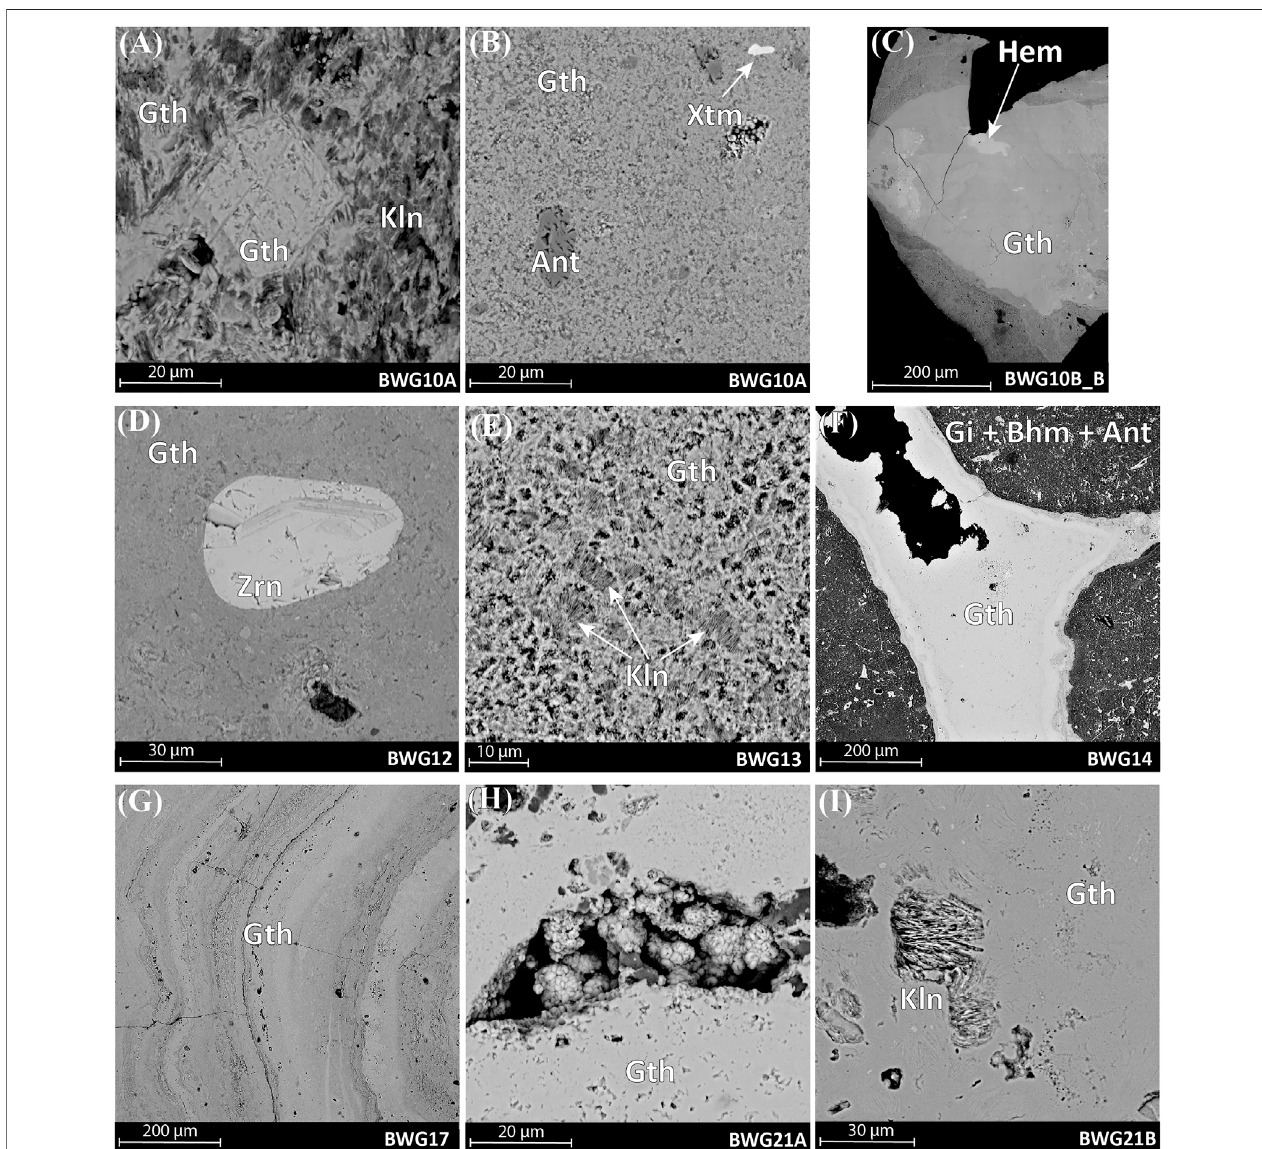
FIGURE5| Scanningelectronmicroscopyimages. (A) Detritalgoethite( G th)surroundedbyintergrownkaolinite(Kln)bookletsandcheckeredsecondary goethite. (B,D) Contaminant can be present in dated aliquots, for example, anatase (Ant), xenotime (Xtm), or zircon (Zrn). (C) Goethite is the main Fe-oxide found in the Brownsbergsample,buthematite(Hem)canbeobserved. (E,I) ThemassiveduricrustfromLeoFalls(BWG13)andtheMine(BWG21B)displaysepigeneticreplacement of kaolinite booklets by goethite. (F,G) Colloform goethite displaying various Al, Si, or Ti contents traduce long-term weathering under different environmental conditions. (F) The bauxite is mainly composed of gibbsite (Gbs) eventually accompanied by boehmite (Bhm) and anatase (Ant). (H) Polycrystalline texture of pure goethite in BWG21A.